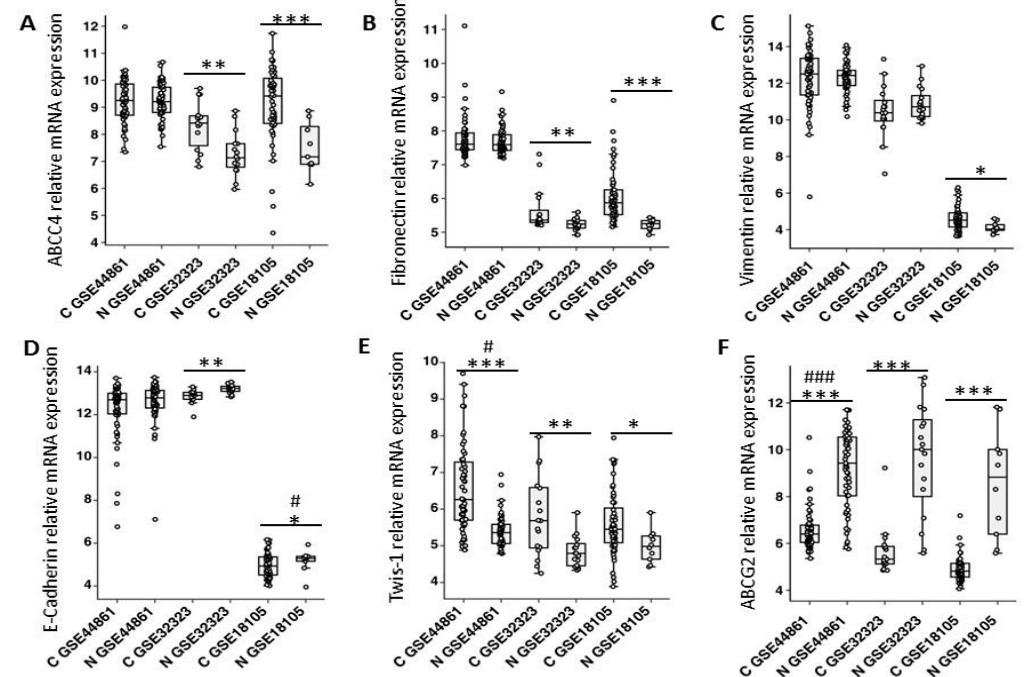
Figure 1. ABCC4 ( A ), ABCG2 ( F ), and EMT marker ( B – E ) mRNA expression in CRC and normal tissue. Microarray data from the public Gene Expression Omnibus (GEO) database (GSE18105, GSE44861, and GSE32323: [20] were analyzed with the respective n for c (cancer) and n (normal): GSE18105 n c = 57 n n = 10 (primary tumors only); GSE44861 n c = 56, n n = 55; and GSE32323 n c = 17 n n = 17. Normality test (Shapiro–Wilk) was performed, followed by the Mann–Whitney U test (*)—* p < 0.05; ** p < 0.005; *** p < 0.001, no statistically significant—no indicator. Additionally, all the normally distributed samples were tested using t -test (#) # p < 0.05; ### p < 0.001. Data density distribution is presented in the Supplementary Materials, Figure S2.